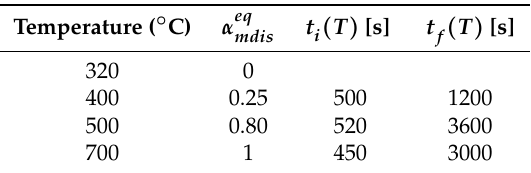
Table 3: Dissolved martensite fraction at equilibrium and initial and (cid:133)nal times ti(T),tf(T) of martensite dissolution with initial and (cid:133)nal normalized fractions: Xi=0.3, Xf=0.9.